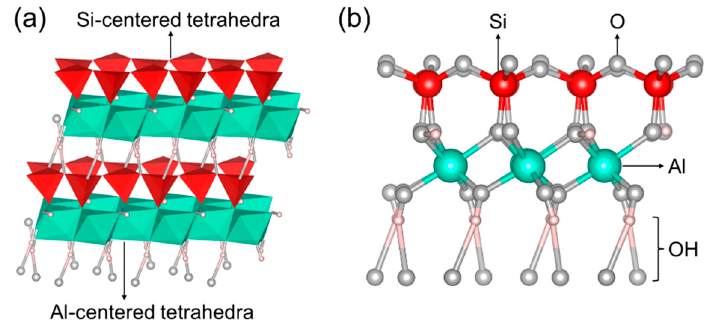
Figure 1. The structure model ( a ), and the stick model ( b ) of kaolinite. (The red color represents Si component, the blue color represents Al component, the gray ball is O atom, and the pink ball is H atom).